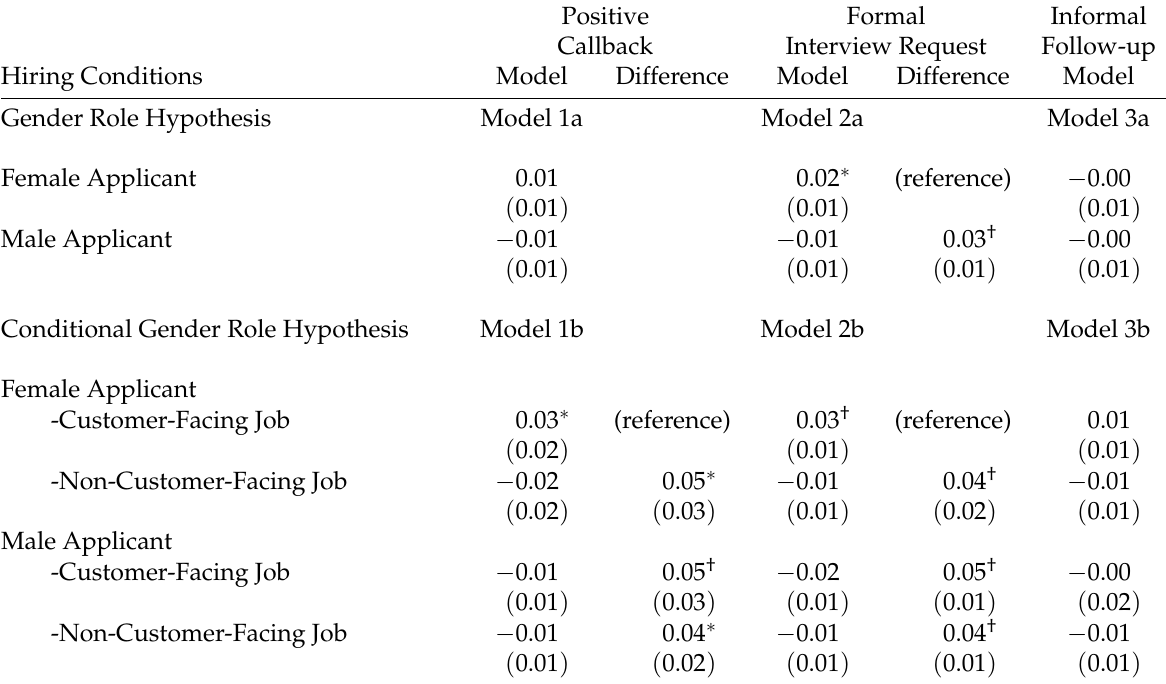
Table 3: Average marginal effect of signals of highbrow taste, interacted with job type and applicant gender, on callback